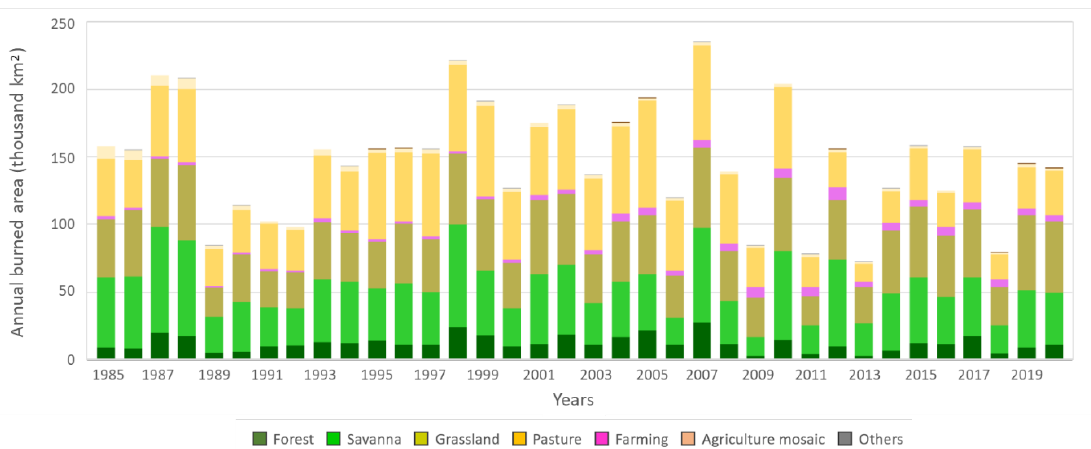
Figure 12. Annual distribution of the burned area by land use and land cover type in Brazil from 1985 to 2020. Table 3. Mean burned area and standard deviation in the main land use and cover classes in Brazil and the Brazilian biomes.